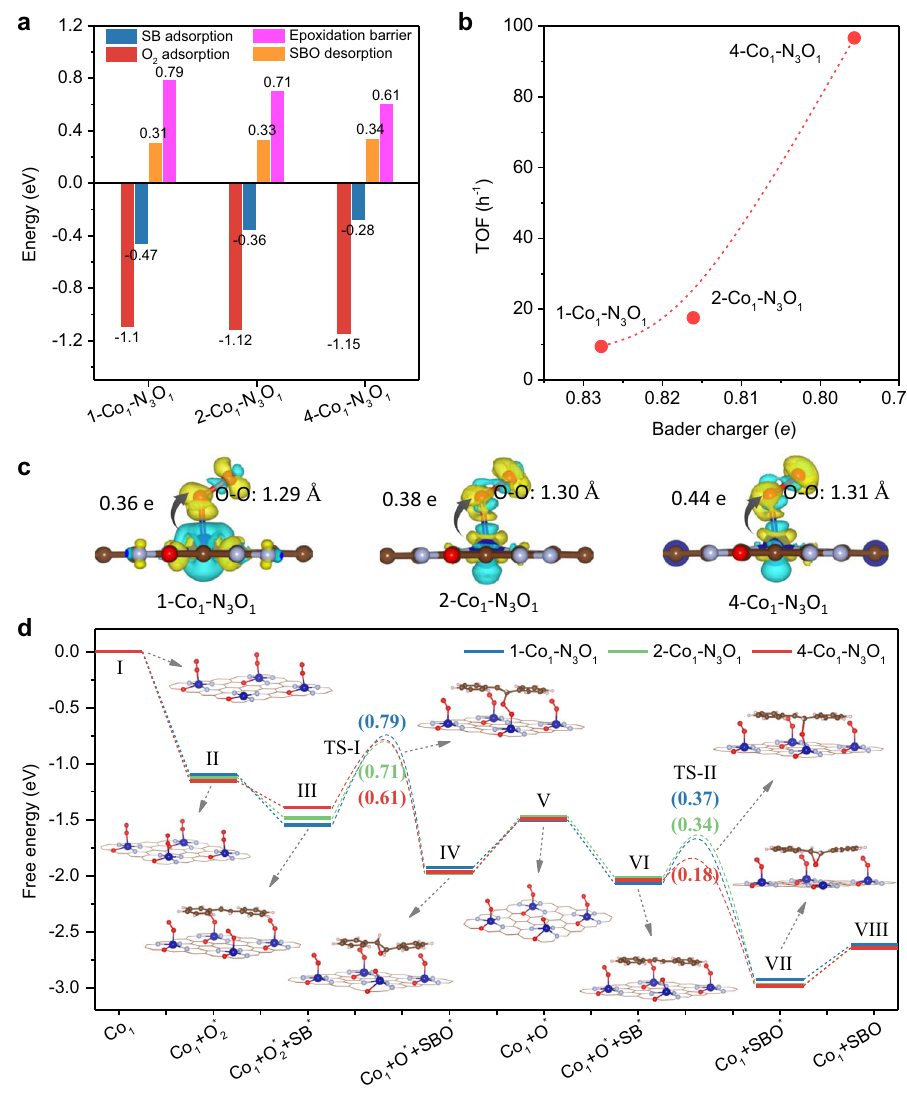
Fig. 5 | Theoretical calculation of adsorption con fi gurations and reaction pathways. a The calculated energies for adsorption O 2 and SB, as well as SBO desorption energies. b The relationship between Bader charge and catalytic activity. c Charge density differences after O 2 adsorption on various x-Co 1 -N 3 O 1